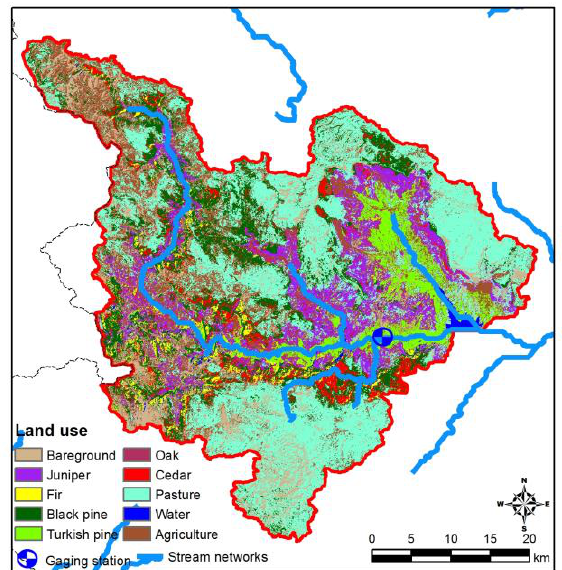
Figure 3. Land use map of the study